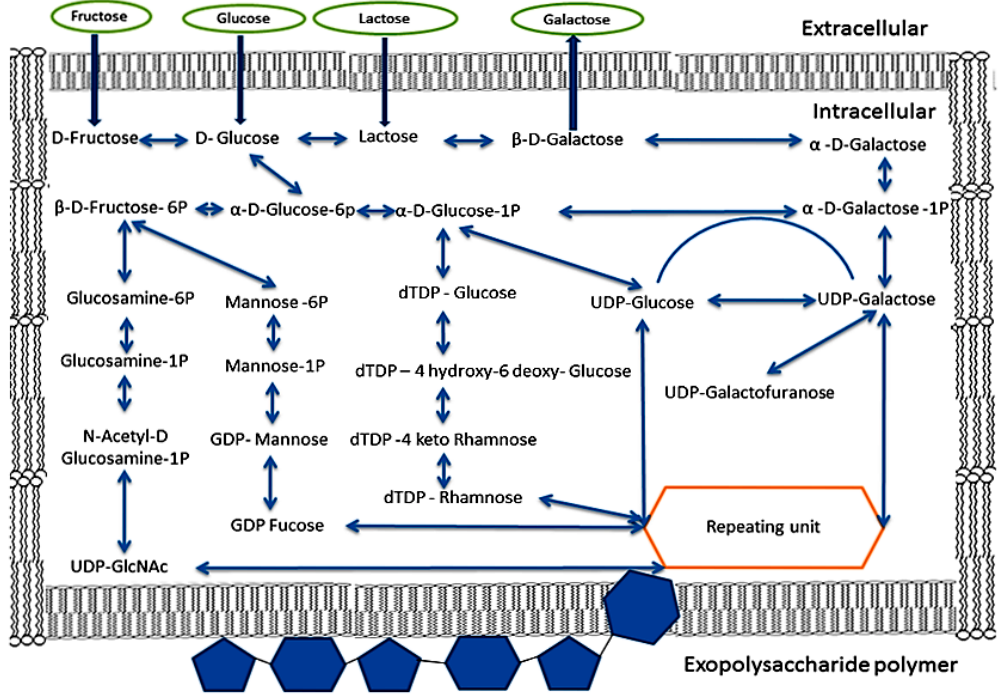
Figure 3. Diagram showing the biosynthetic pathways involved for the production of exopolysaccharides from lactose, fructose, galactose and glucose by lactic acid